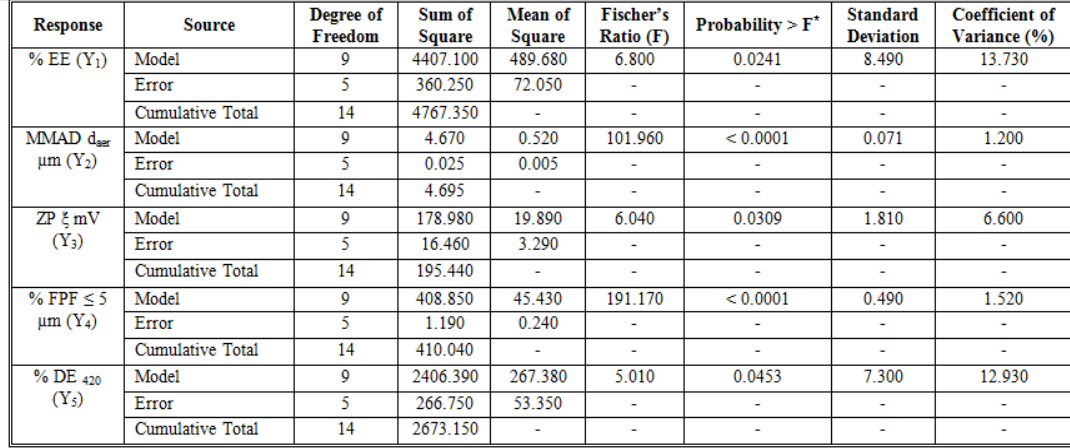
*Probability > F is the significance level and a value < 0.05 considered